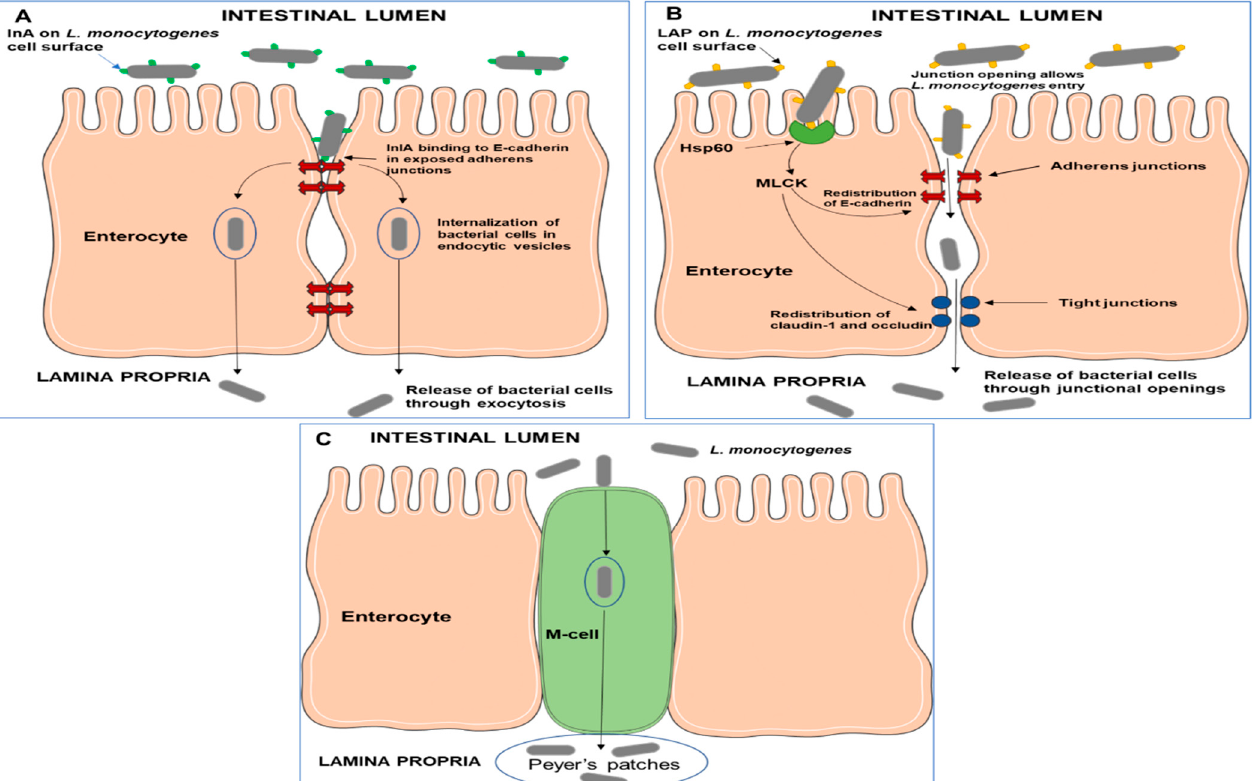
Figure 2. Pathways of the L. monocytogenes invasion of the intestinal barrier. In the InlA-mediated transcytosis ( A ), bacterial cells are taken into the enterocytes by endocytosis through the interaction of InlA and any exposed E-cadherin receptors followed by subsequent exocytosis into the lamina propria. In the LAP-mediated translocation ( B ), the interaction between the bacterial surface protein LAP and the receptor Hsp60 causes an opening of tight junctions facilitating the movement of bacterial cells into the lamina propria. In the M-cell-mediated pathway ( C ), bacterial cells are passively taken in by M-cells and released by exocytosis into the lamina propria. The schematic art pieces were obtained from Servier Medical art (https://smart.servier.com). Servier Medical Art by Servier is licensed under a Creative Commons Attribution 3.0 Unported